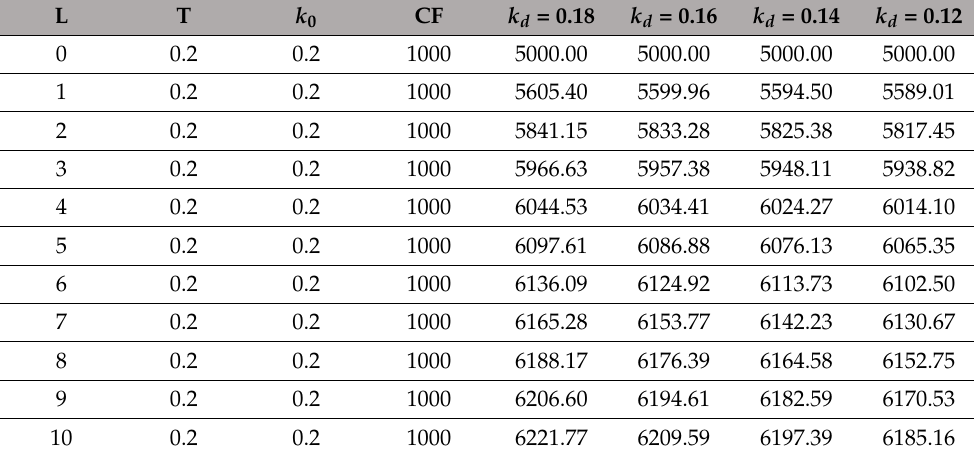
Table A8. Dependence of the company capitalization, V , on leverage level L at p = 12 and different